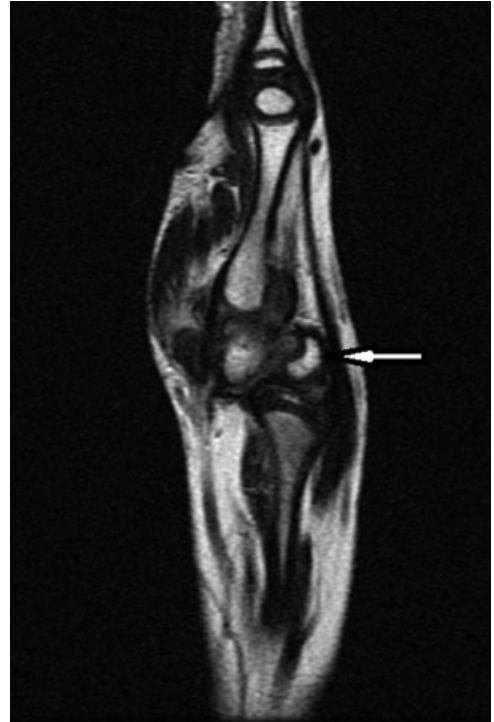
Fig. 2 Magnetic resonance imaging before surgery. Perilunate wrist dislocation lateral view.